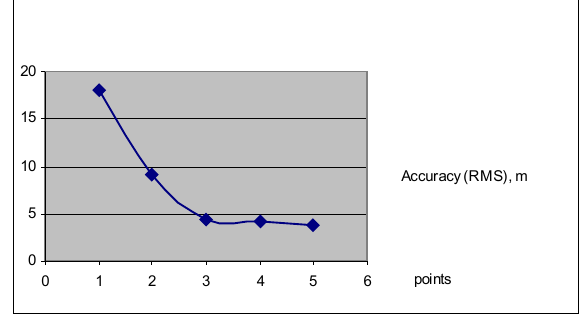
Figure. 6. Georeference accuracy of CCD matrixes block External orientation accuracy for synthesized coverage with 7 control points is